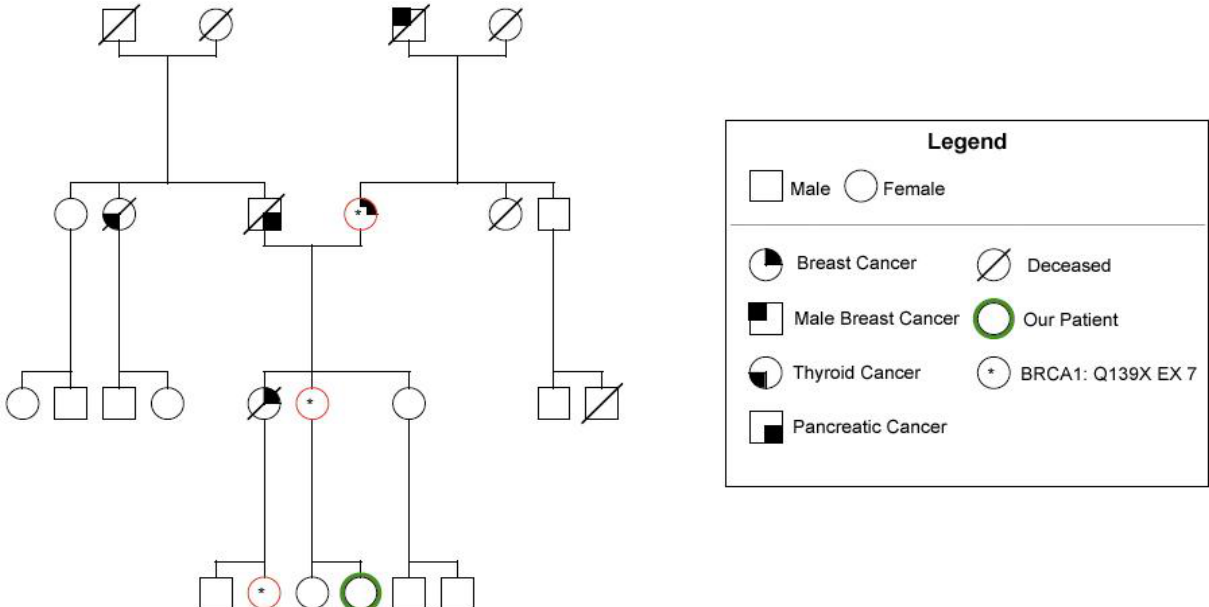
Figure 1. Genealogical diagram of the family with indication of the subjects mutated and the type of cancers.